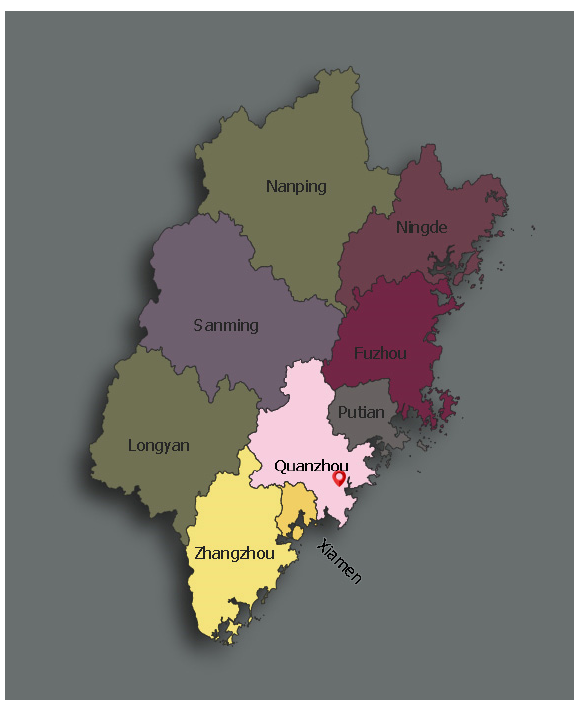
Figure 1. The special education school in Jinjiang City, Fujian Province. Table 3. General steps for play behavior in children with